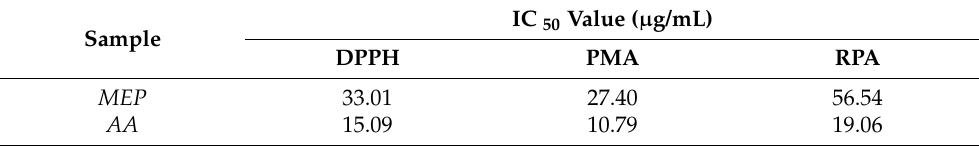
Table 2. IC50 value of MEP for antioxidant capacity determined by DPPH, PMA, and RPA.